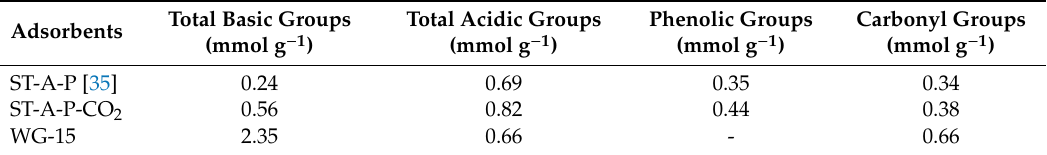
Table 4. Functional groups available on the studied adsorbents.